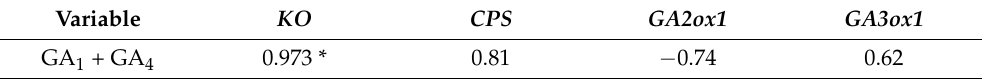
Table 4. Correlations between the concentrations of gibberellin and its metabolism-related genes. Variable